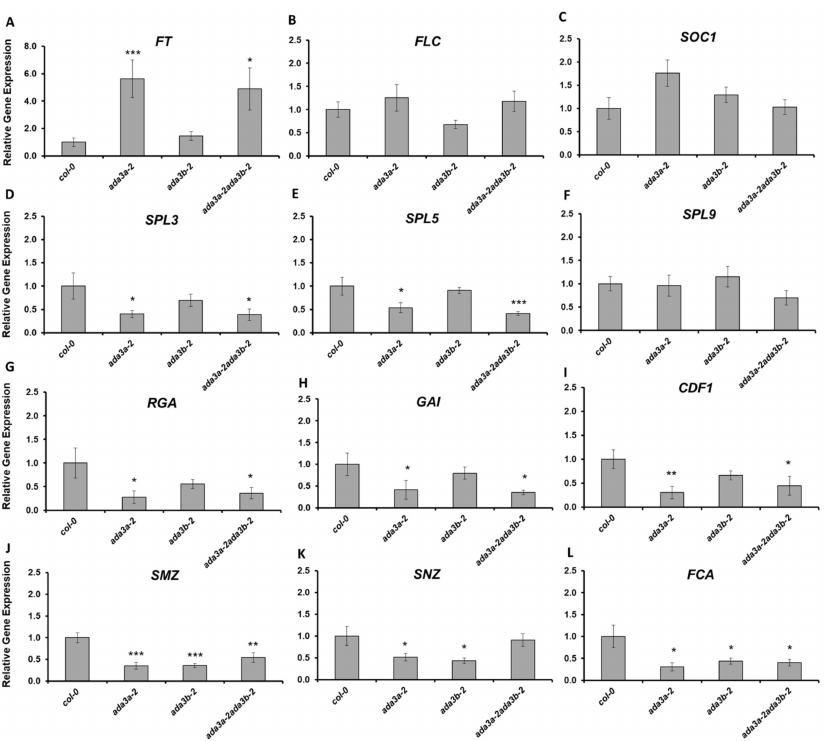
Figure 6. The effect of ADA3a and ADA3b on the flowering related gene expression under long-day conditions. Gene expression analysis of FT ( A ), FLC ( B ), SOC1 ( C ), SPL3 ( D ), SPL5 ( E ), SPL9 ( F ), RGA ( G ), GAI ( H ), CDF1 ( I ), SMZ ( J ), SNZ ( K ), and FCA ( L ) in the wild-type, ada3a-2 , ada3b-2, and ada3a-2ada3b-2 plants, quantified by reverse transcriptase (RT)-qPCR. Statistical significance calculated by t-test, * p < 0.05, ** p < 0.01, *** p <